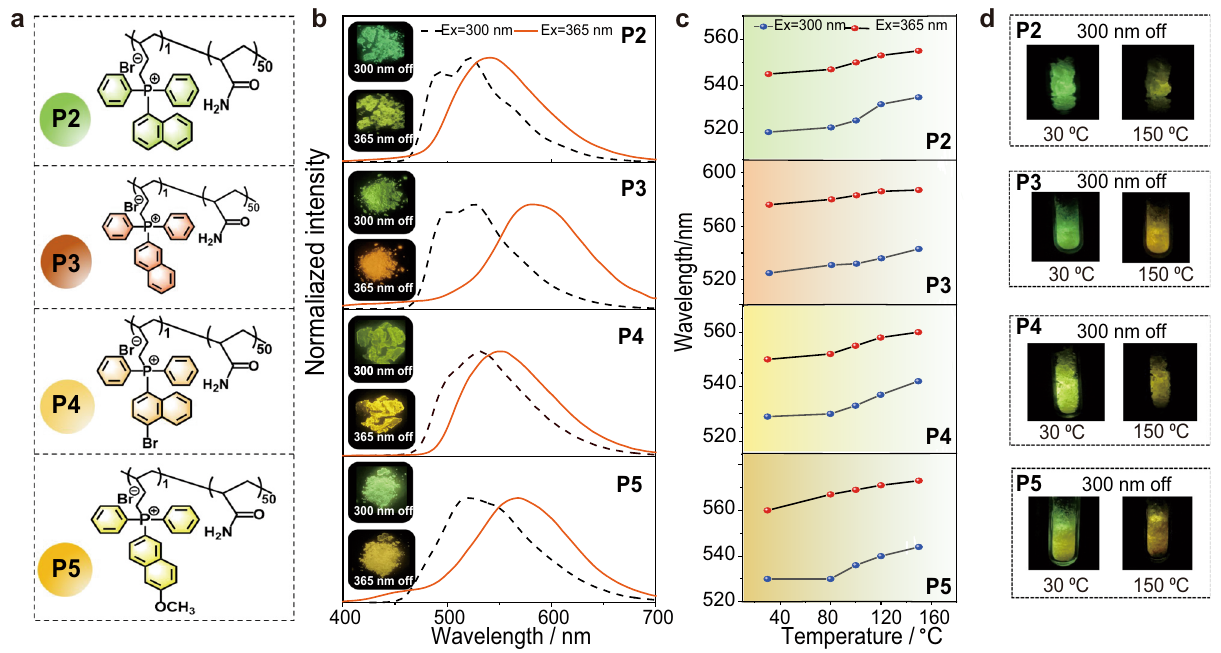
Fig. 4 | Chemical structures of P2-P5 and their RTP properties. a Chemical structure of P2-P5. b Ex-De phosphorescence spectra of P2-P5, and their photo- graphs under 300/365nm excitation. c Phosphorescence spectra of P2-P5